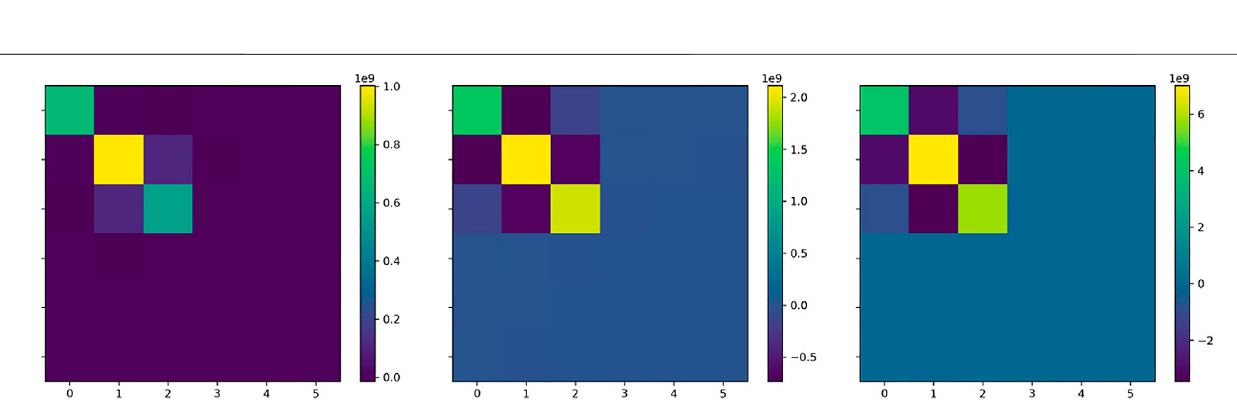
Frontiers in Applied Mathematics and Statistics |